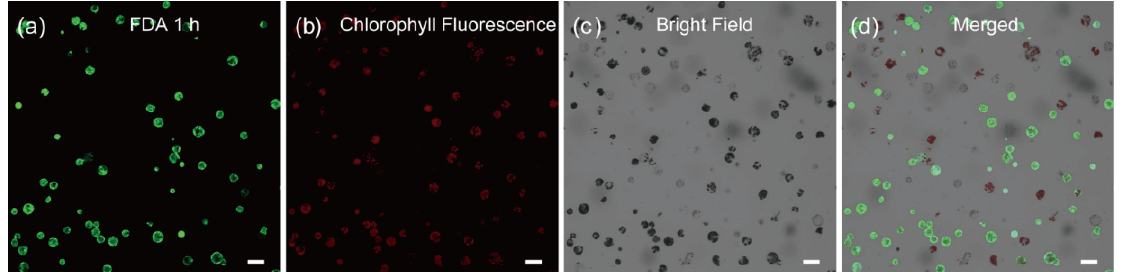
Figure 2. Viability assay of C. pumila mesophyll protoplasts after 1 h FDA staining. Protoplasts stained with FDA were imaged under ( a ) GFP, ( b ) chlorophyll fluorescence, ( c ) bright field, and ( d ) merged channel, respectively. The active cells are reflected by the green fluorescence signals. Scale bars, 50 μ m.